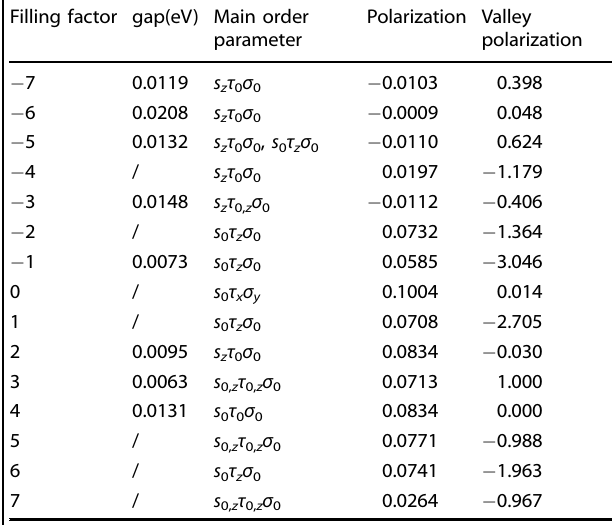
Table 2. Gaps, main order parameters, electric polarization, and valley polarization of the Hartree – Fock ground states at different integer fi lling